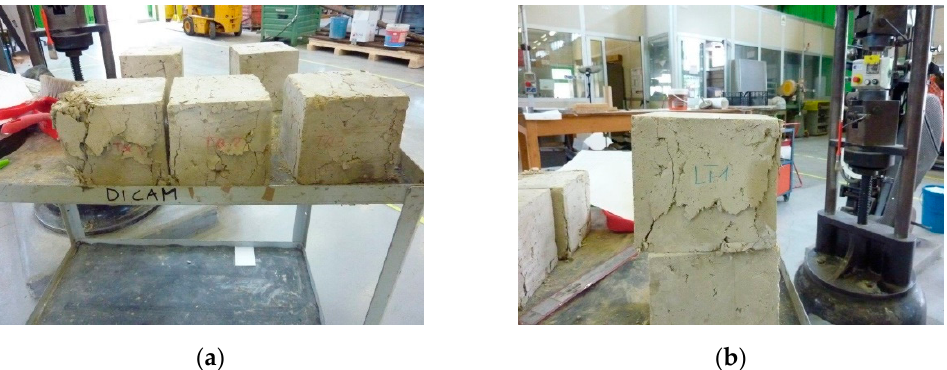
Figure 11. Appearances of the specimens after removal from the testing machine: ( a ) three TQ specimens in the foreground; and ( b ) detail of one LT specimen.